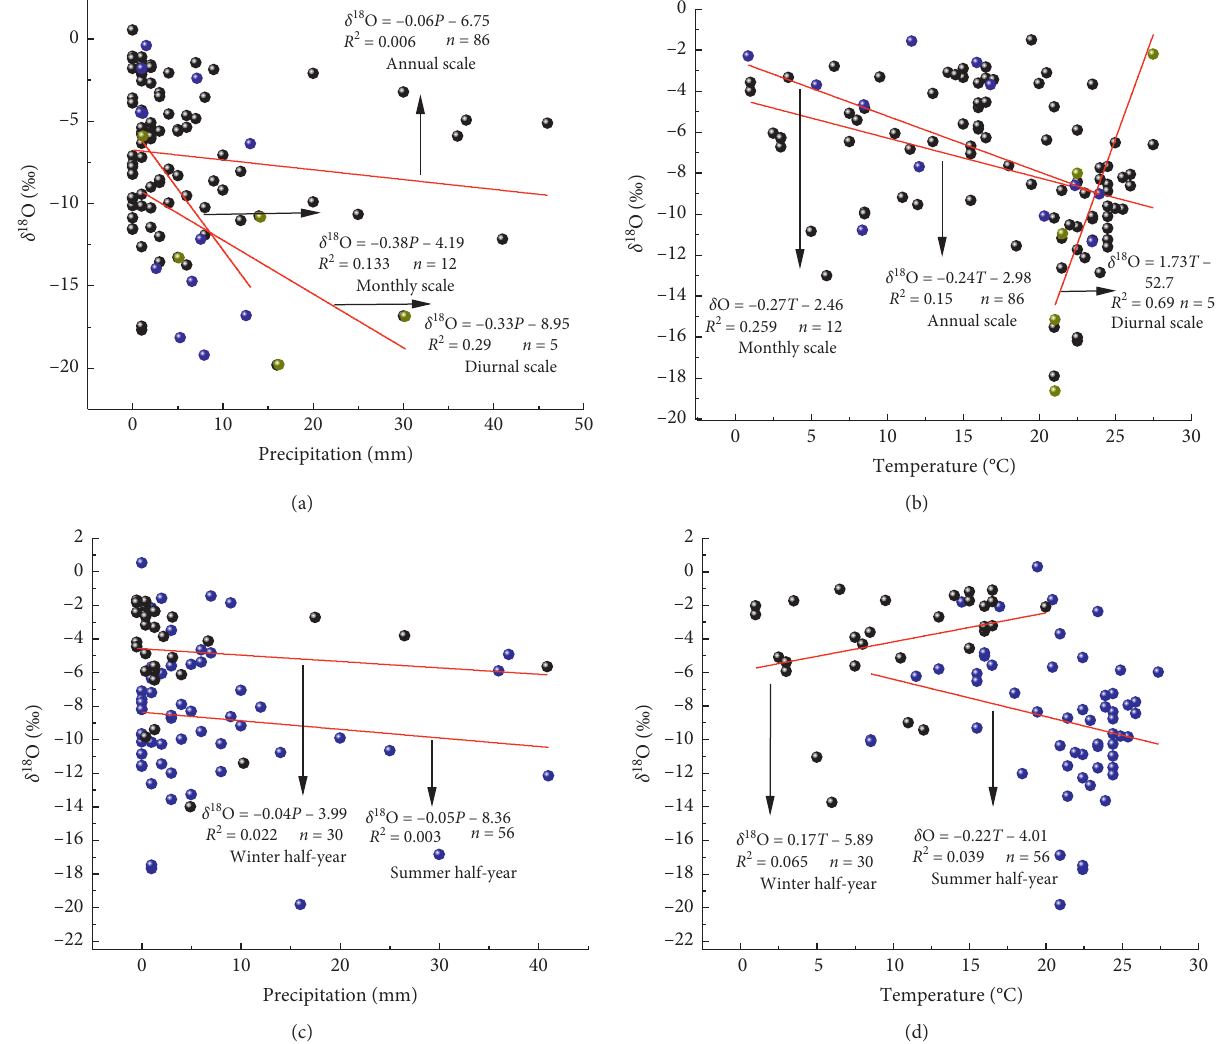
Figure 1: Correlations between δ 18 O in precipitation and meteorological parameters in the Guanling